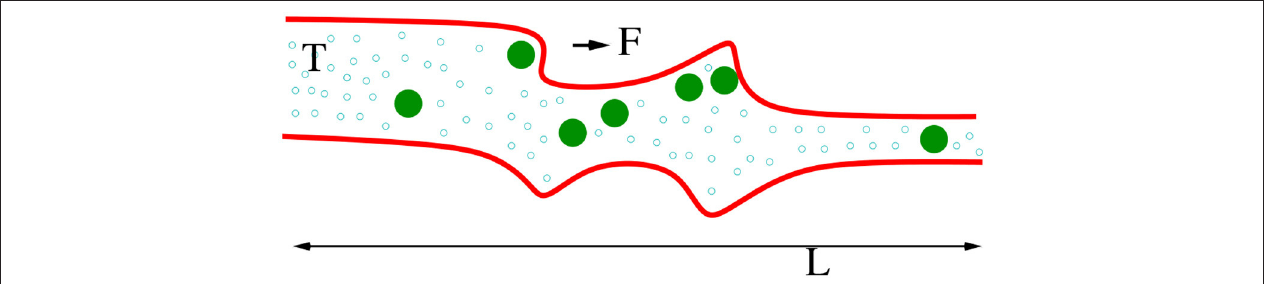
FIGURE 3 | Flow in a rough channel with periodically repeated cells of length L . Colloids are pushed with force F in a thermal bath at temperature T . Trapping may occur causing the current to drop at larger F